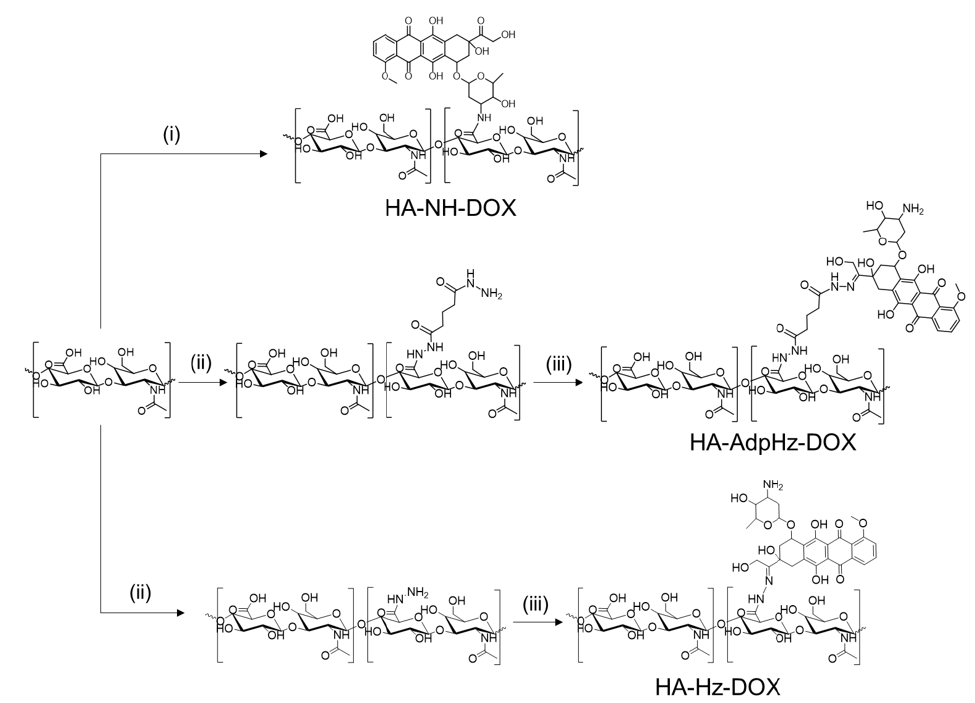
Table 1. Characterization of HA-DOX